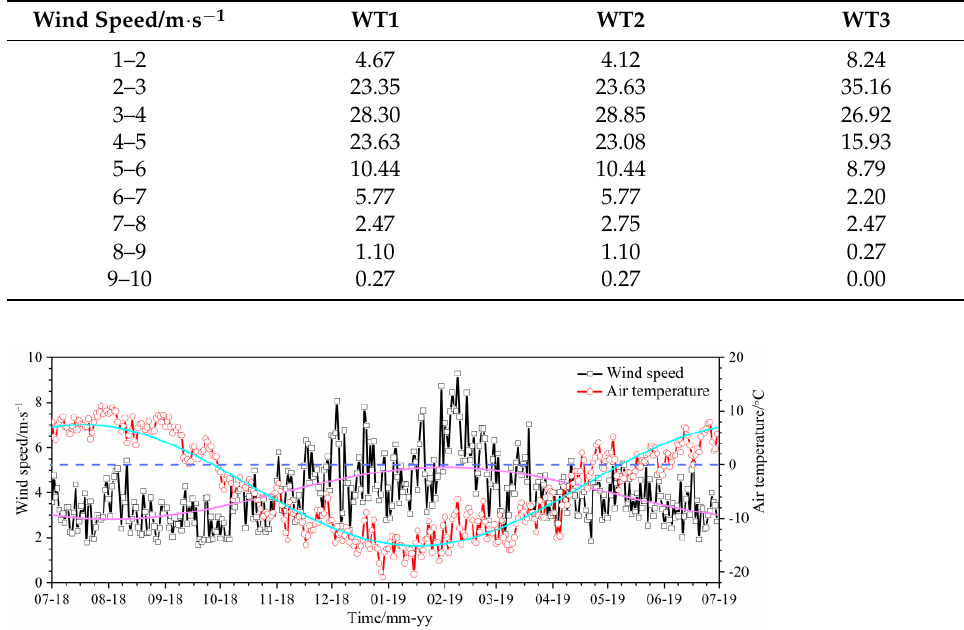
Figure 5. Variations in the mean daily wind speed and the mean daily air temperature at the WT1 from July 2018 to July 2019.